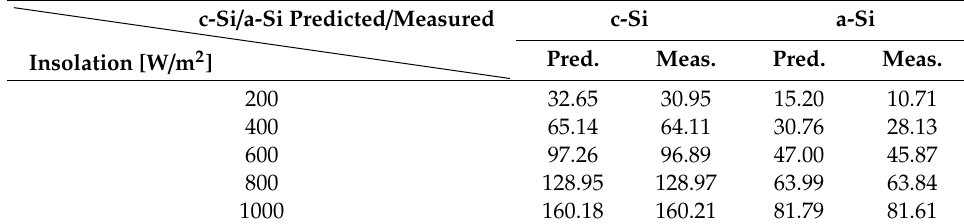
Table 5. Comparison of the generated power of the PV modules between the laboratory test (measured) and the Sandia model (predicted).